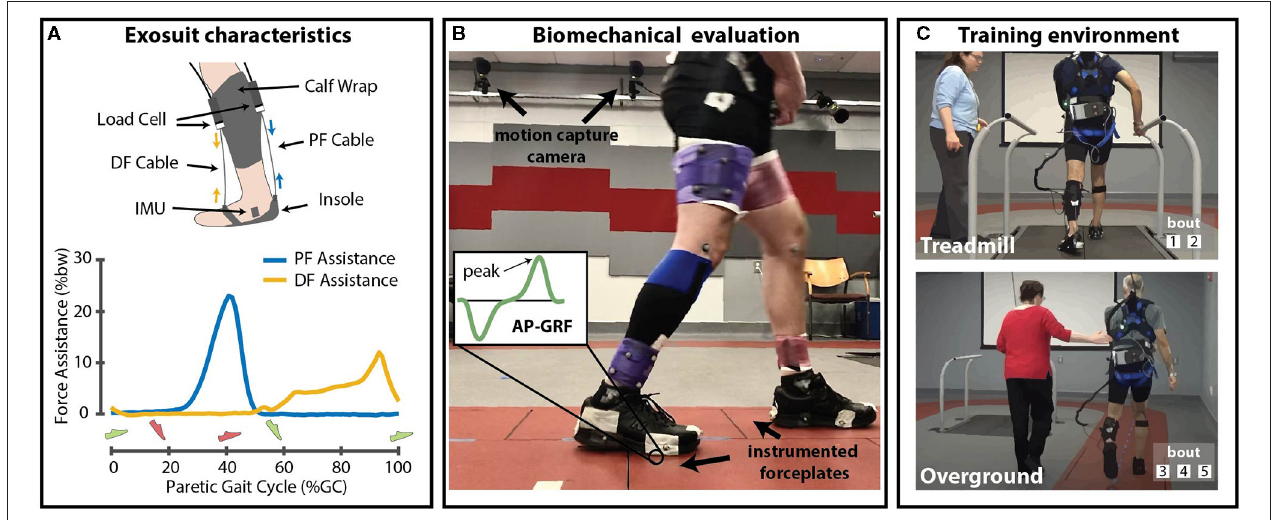
FIGURE 2 | (A) Schematic of soft robotic exosuit with representative force profiles for dorsiflexion and plantarflexion assistance. (B) Laboratory setup for biomechanical evaluation of overground walking. (C) Illustration of Robotic Exosuit Augmented Locomotion (REAL) training, administered by a physical therapist on the treadmill and overground. DF, Dorsiflexion; PF, Plantarflexion; AP-GRF, Anterior-posterior ground reaction force; %bw, Percent body weight; IMU, Inertial measurement unit. (A) Green shoe refers to paretic foot, and red shoe refers to non-paretic